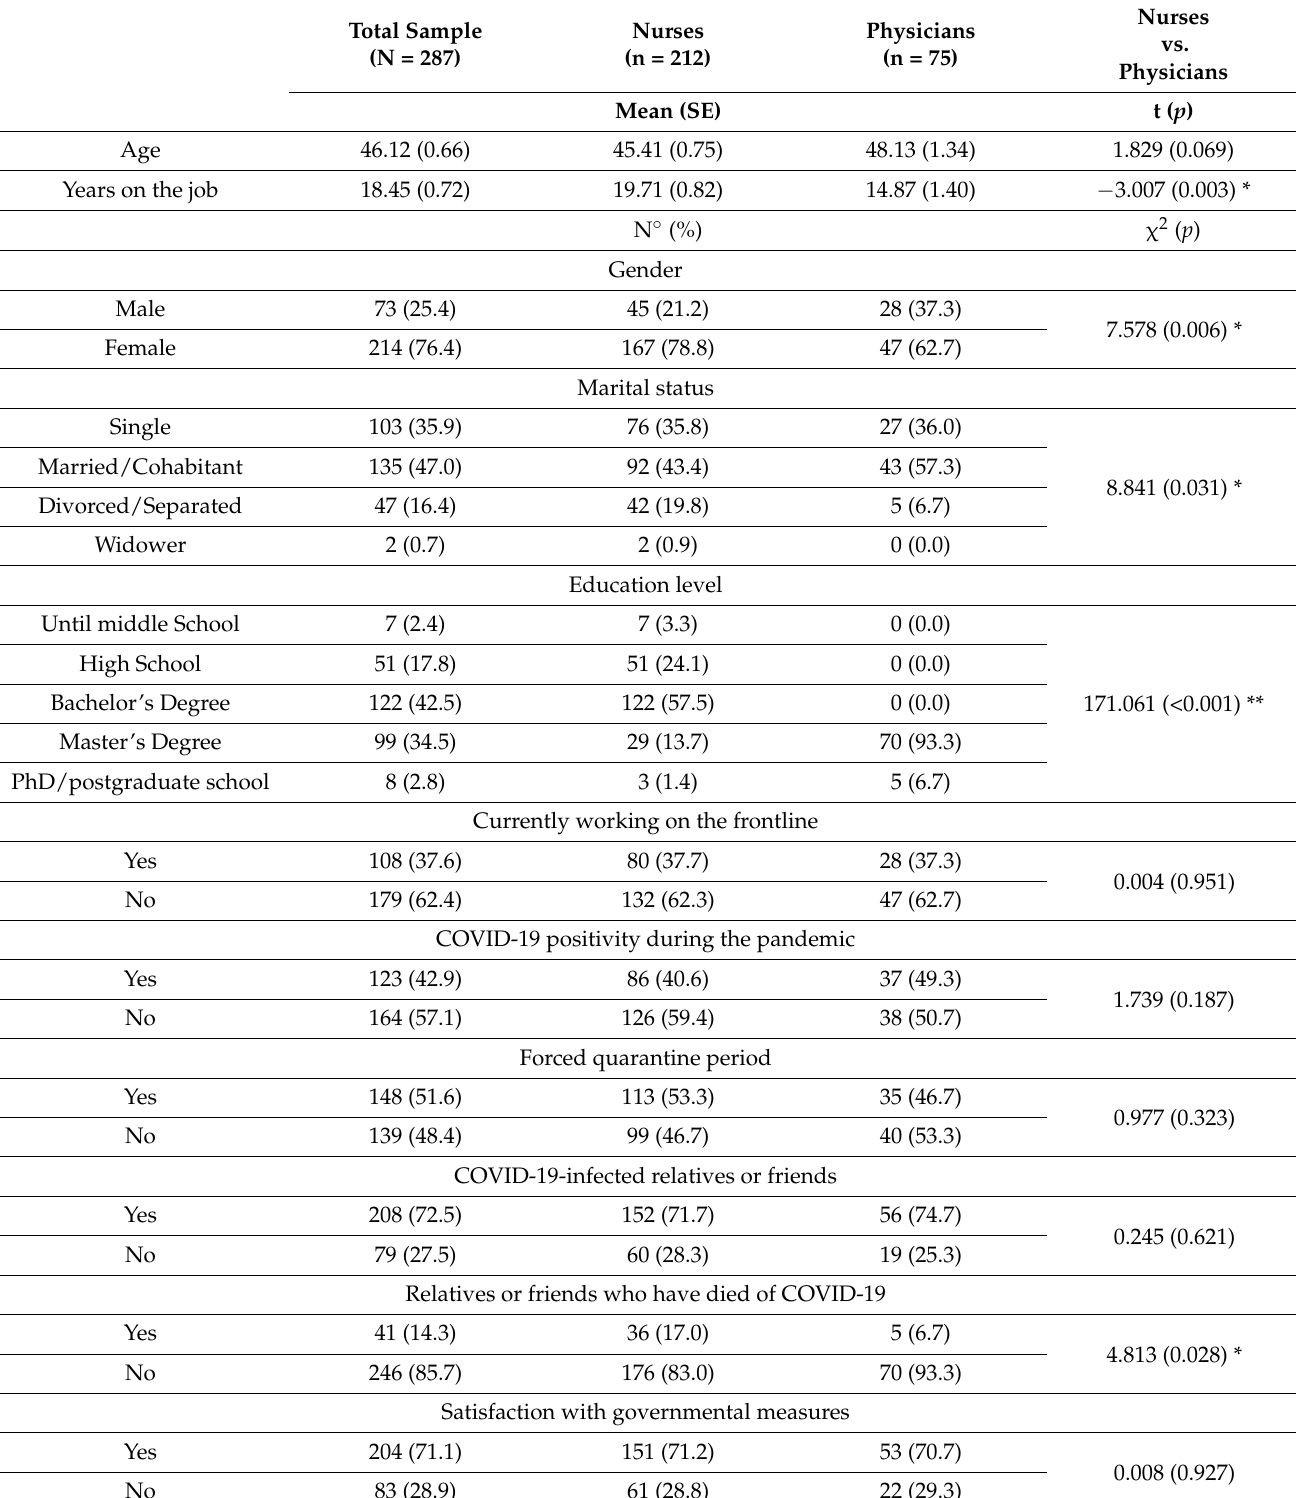
Table 1. Socio-demographic, occupational, and COVID-19-related characteristics in the total sample, nurses and